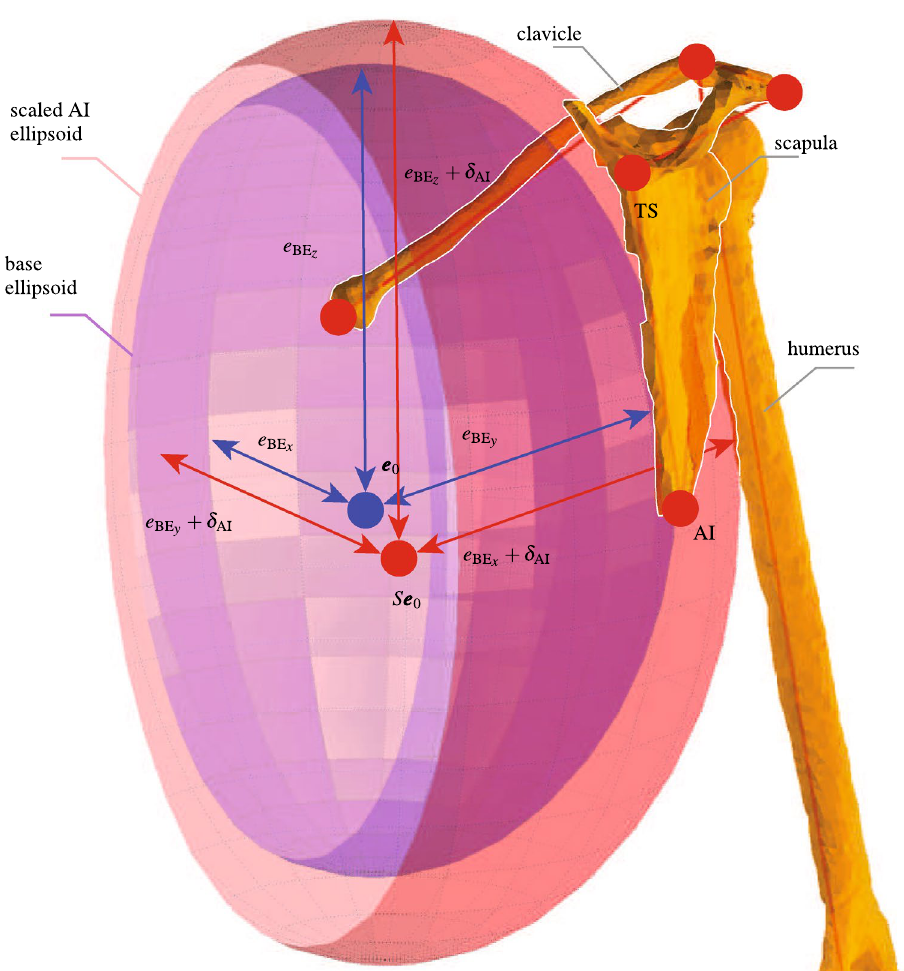
Figure 3. Scaling the ribcage ellipsoid containing AI. A base ellipsoid (blue) is dilated by δ AI to obtain the ribcage ellipsoid AI (red). The base ellipsoid is centered at e 0 with axes equal to e BE x , e BE y , and e BE z . The center of the scaled AI ellipsoid is also obtained by scaling e 0 with S . Scaling the TS ribcage ellipsoid follows the same procedure and results in an ellipsoid centered at S e 0 and dilated by δ TS